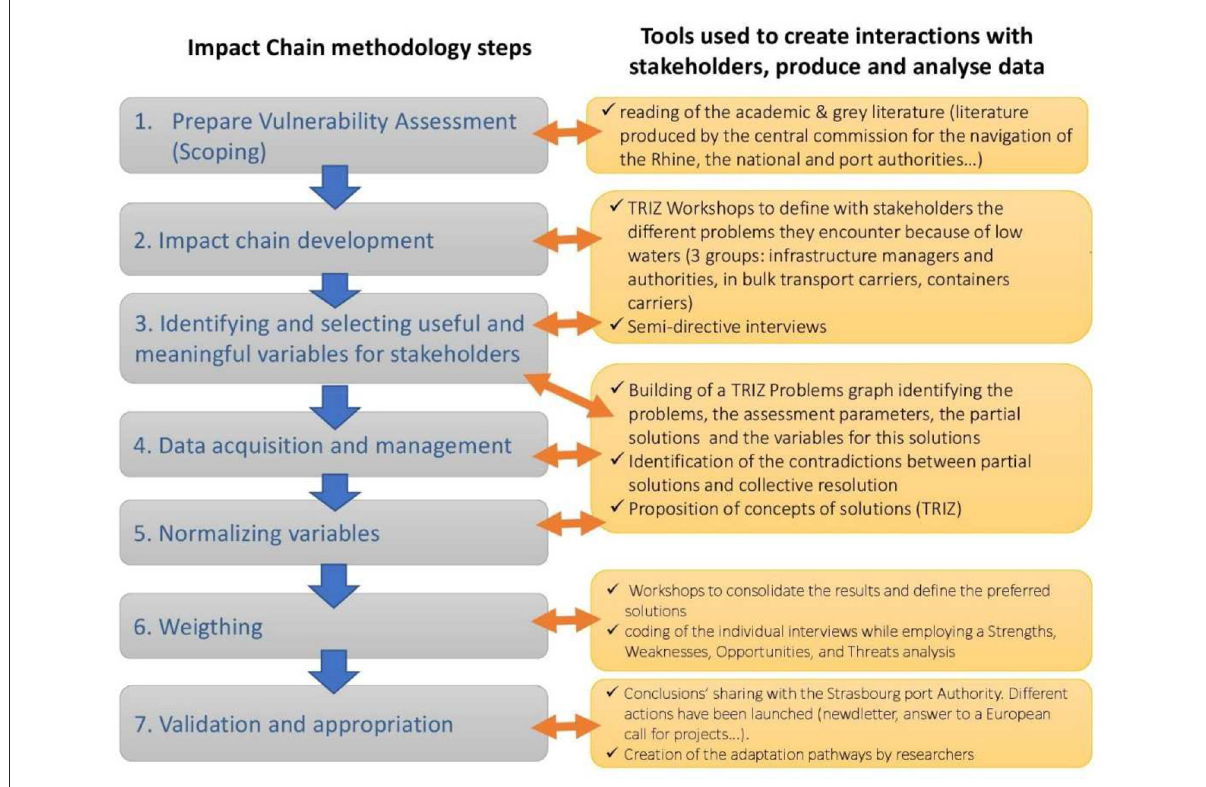
FIGUREA2 Methodology: Impact chain methodology in combination with TRIZ and semi-directive